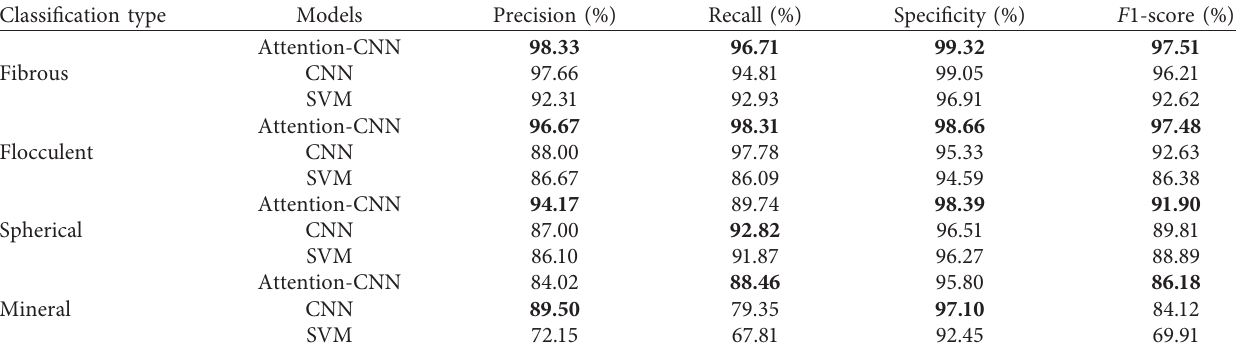
Table 3: The four evaluation indexes of Attention-CNN, CNN, and SVM. Classification